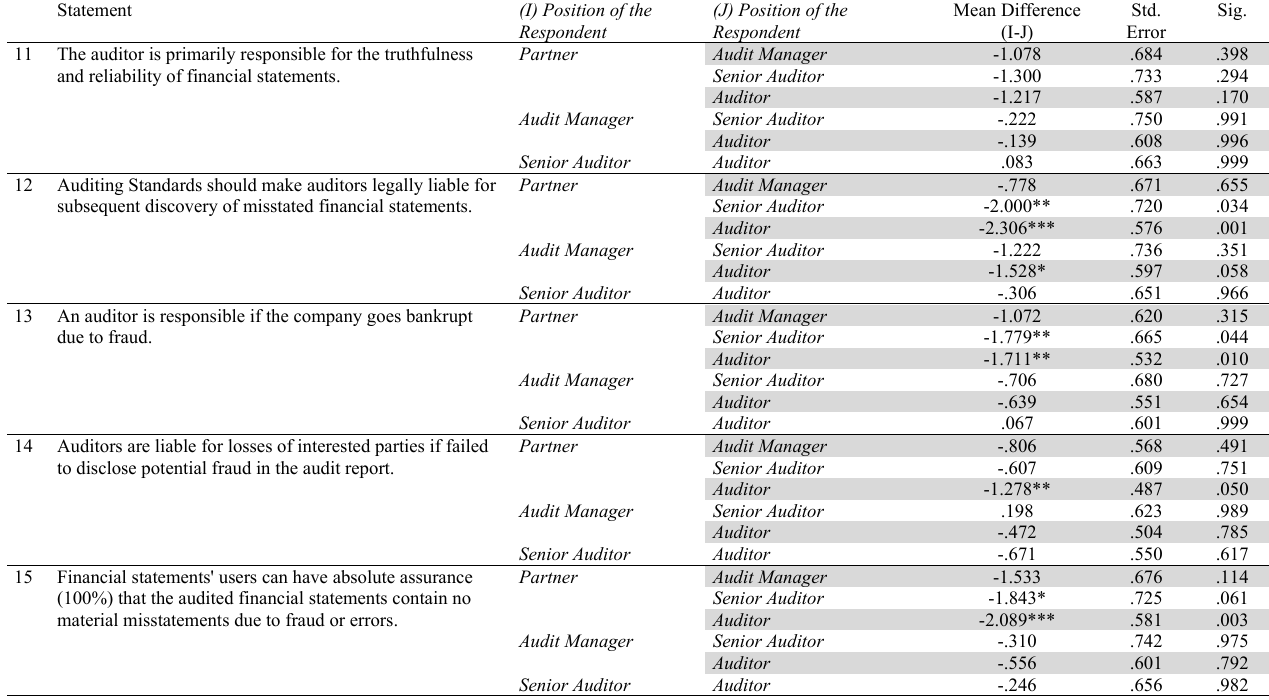
Post Hoc Tests (Multiple Comparisons)